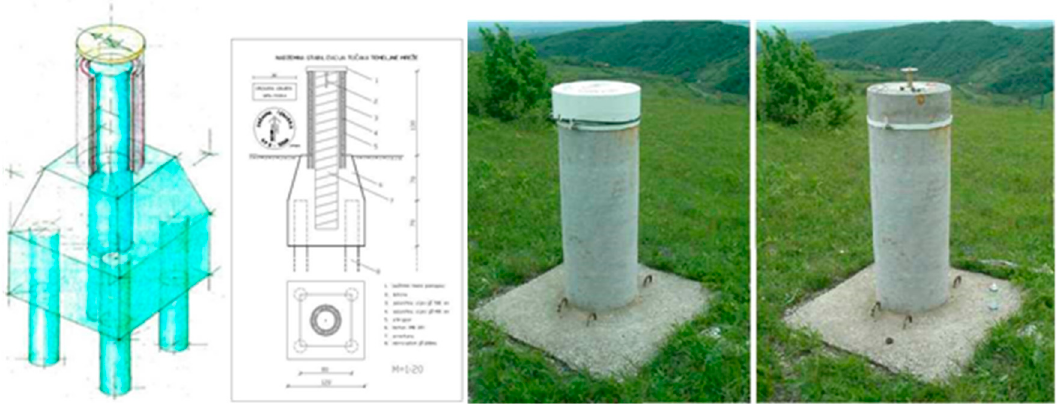
Figure 4. Sketch of the pillar of geodynamic points and photo of built pillars.